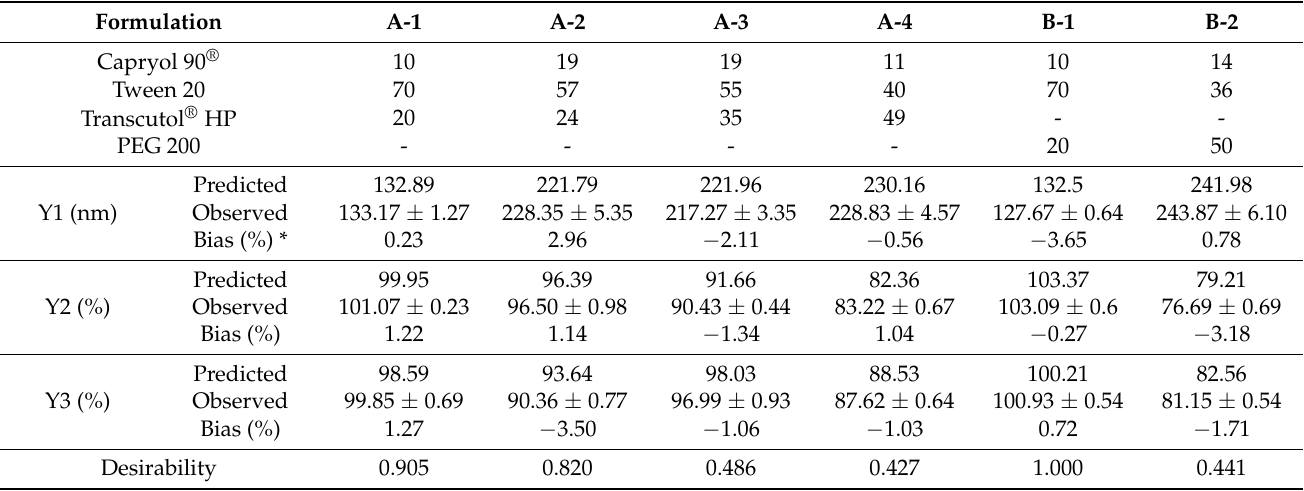
Table 4. Results of numerical optimization and evaluation of tolvaptan-loaded